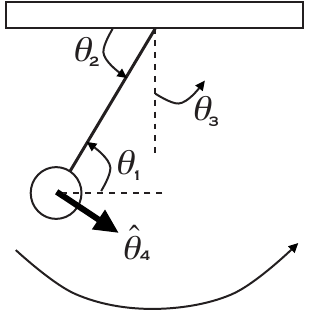
FIG. 4. Derek and Wes use four definitions of (cid:1) at different points in the two miniviews. Contrast their choices with the physi- cist choice presented in